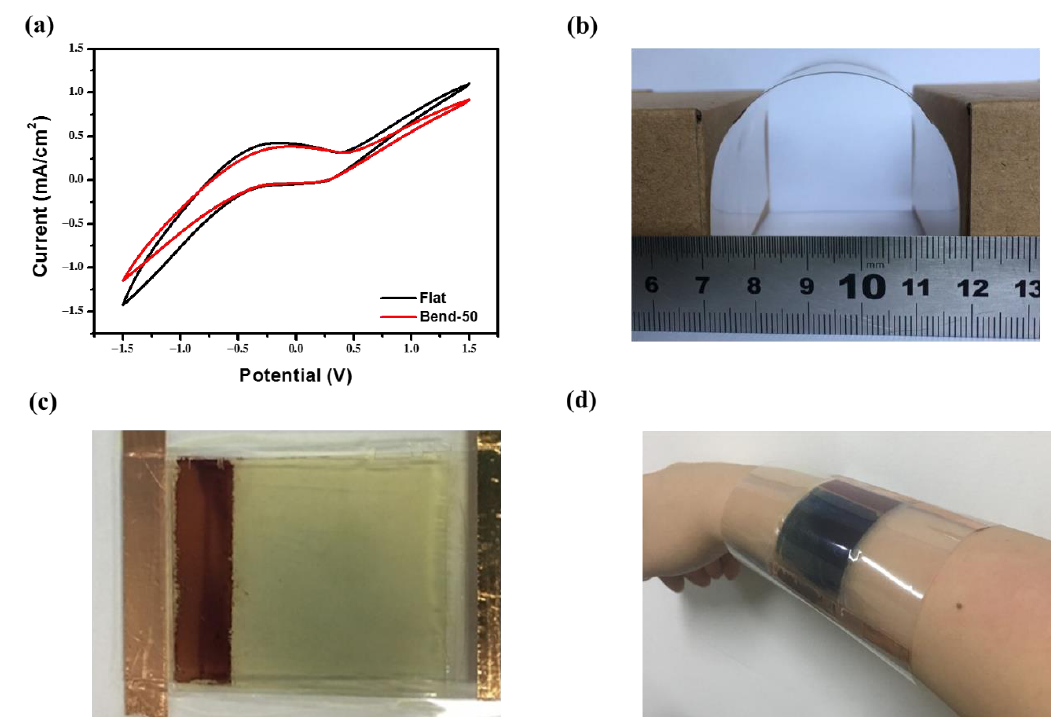
Figure 7. ( a ) The cyclic voltammetry curve of the PECD at the flat state and after 50 bends; ( b ) photograph of the bend state; ( c ) photograph of the enlarged PECD at the bleached state; ( d ) photograph of the enlarged PECD in the wearable field.